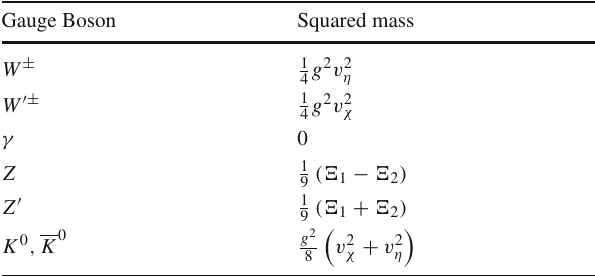
Table 3 Physical gauge bosons mass spectrum Gauge